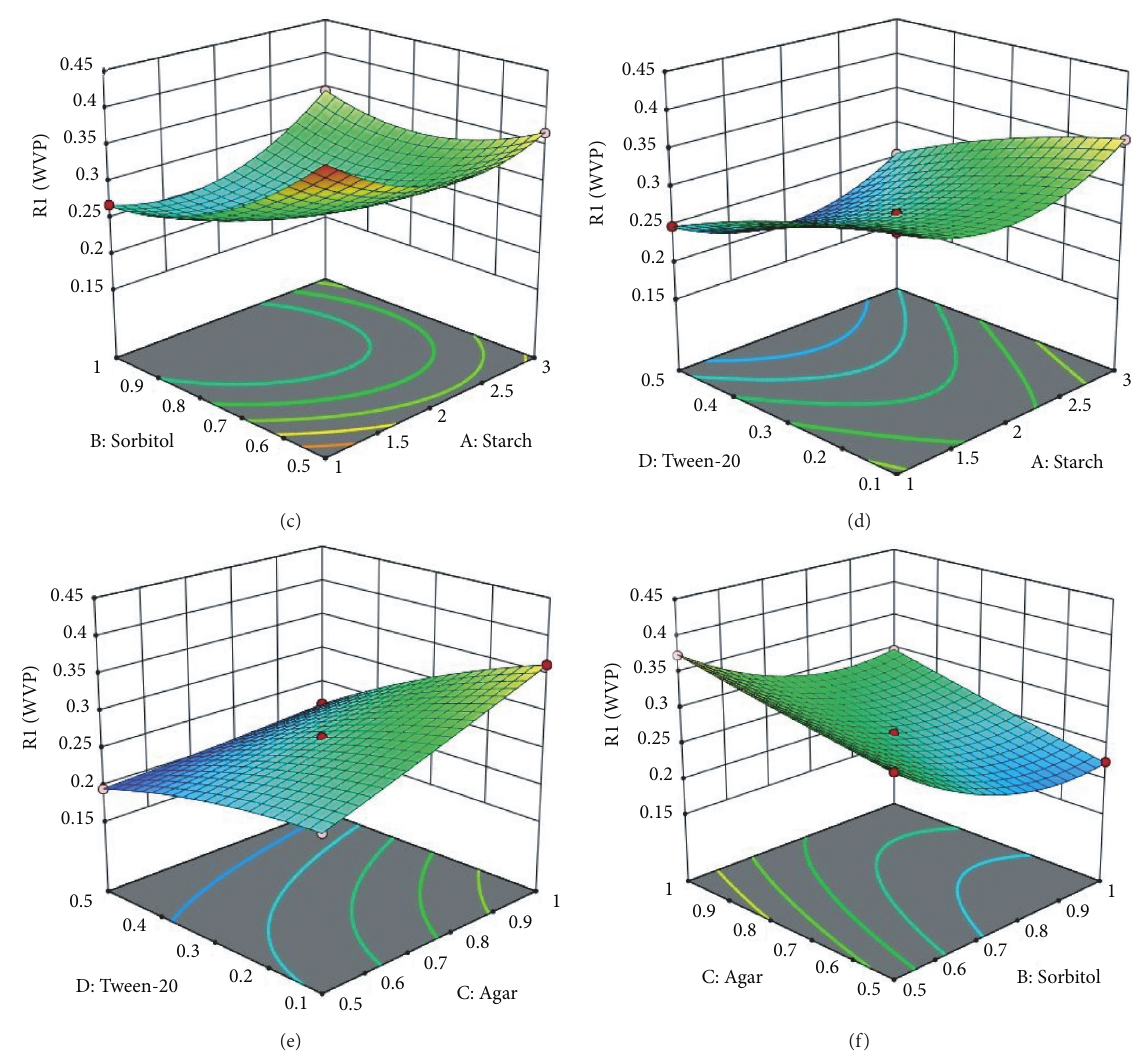
Figure 3: 3D surface showing the interaction impacts of process variables on